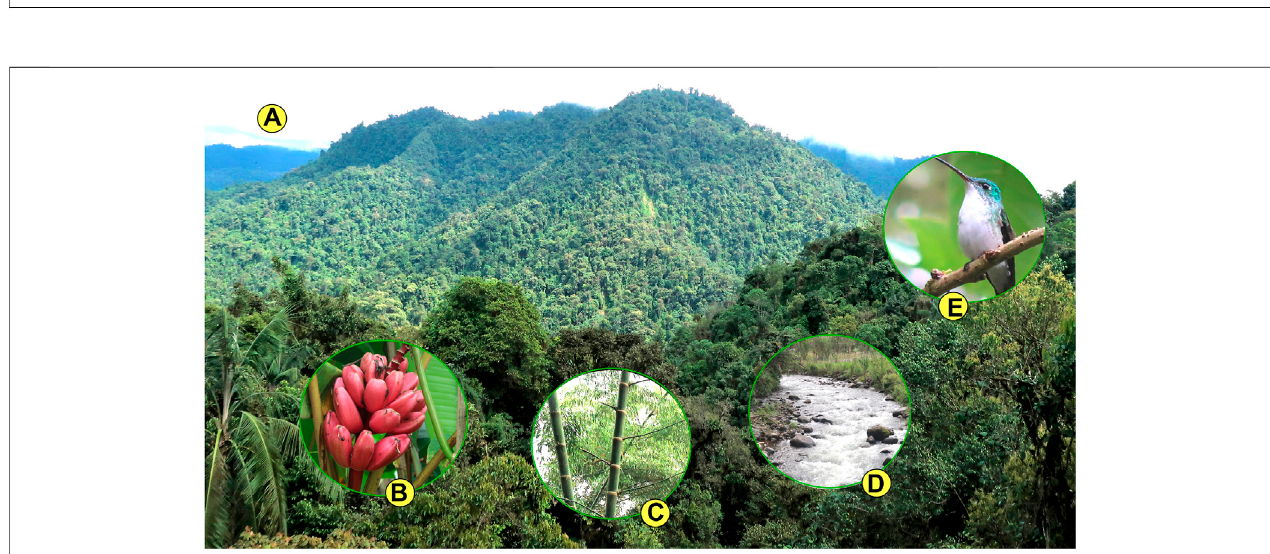
FIGURE 2 | Mountainous, cloud forests (A) completely surround our study area in Mindo, Ecuador. Ecosystem services from these forests include (B) food, such as plantains; (C) building materials and carbon sequestration by Guada angustifolia , the native bamboo; (D) water; and biodiversity of epiphytes, such as orchids, and vertebrate species, such as hummingbirds (E)